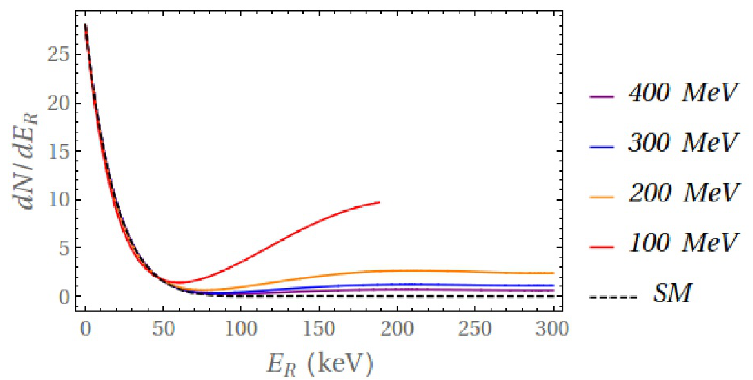
(7) (7) , assuming ^ = 0 : 1 GeV (cid:0) 3 , for four 4 4 Q C